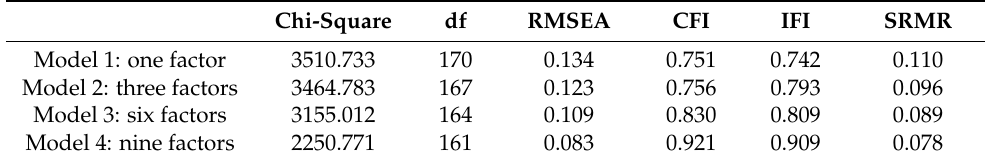
Table 2. Goodness of fit indices of the alternative measurement models on measured variables. Chi-Square